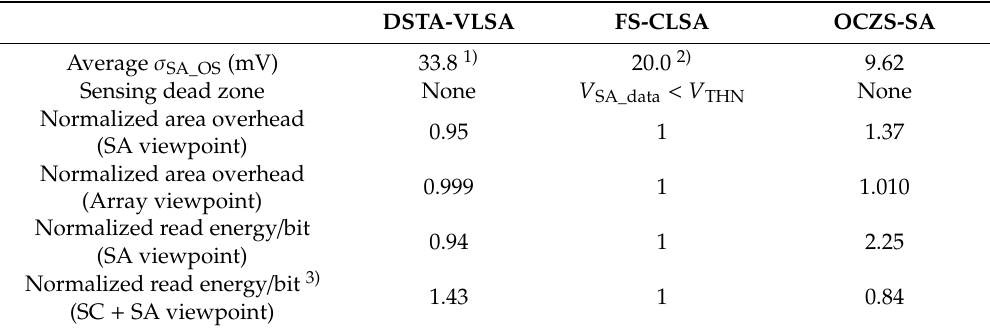
Table 1. Performance summary and comparison between the proposed OCZS-SA and conventional latch-type SAs.